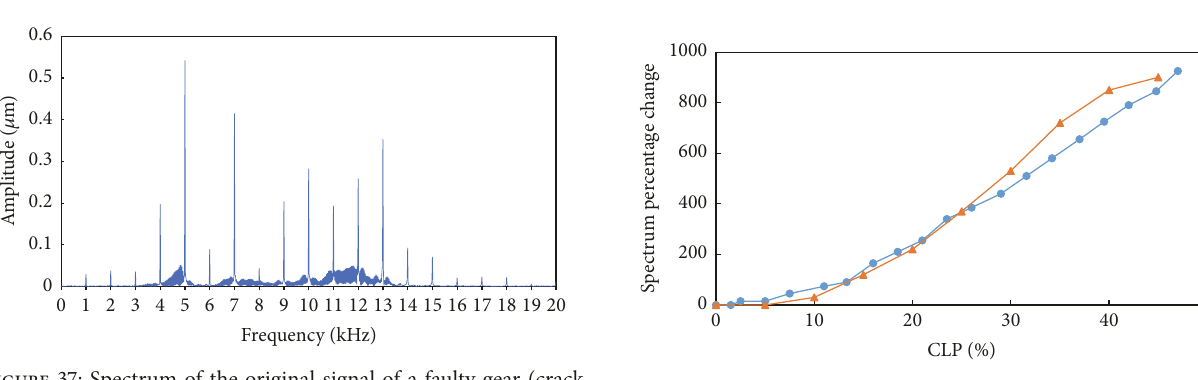
Figure 37: Spectrum of the original signal of a faulty gear (crack ratio = 45%).